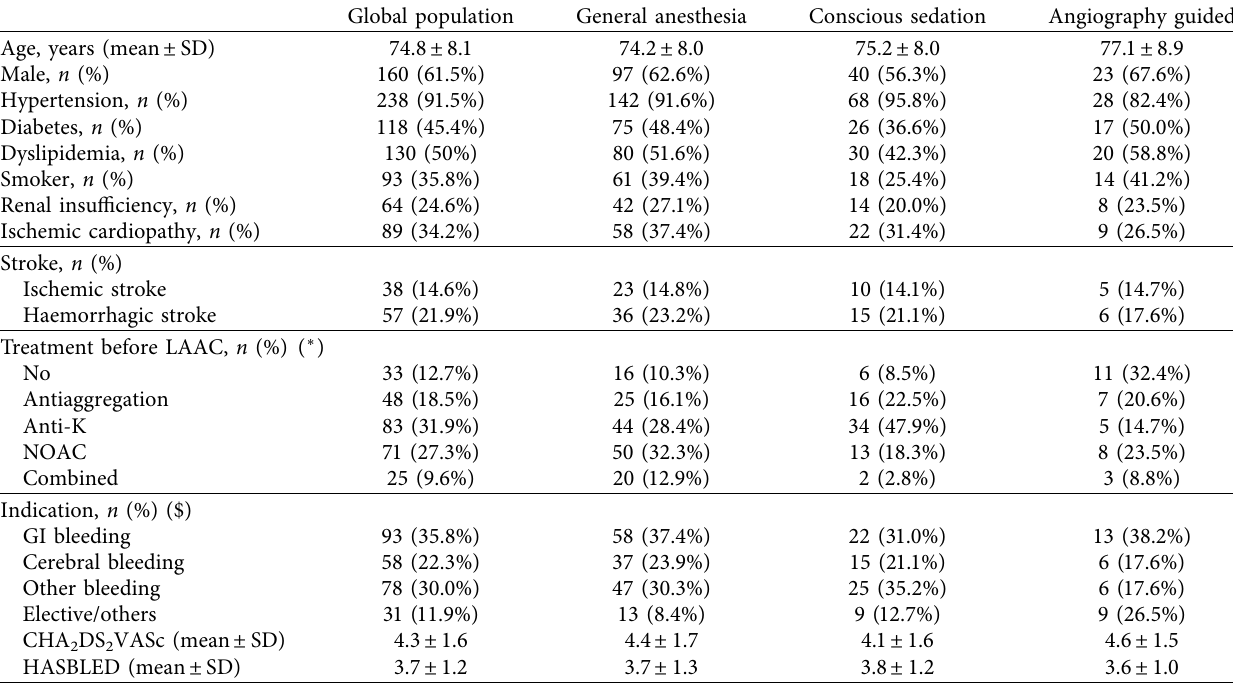
Table 1: Baseline clinical characteristics at time of LAAC